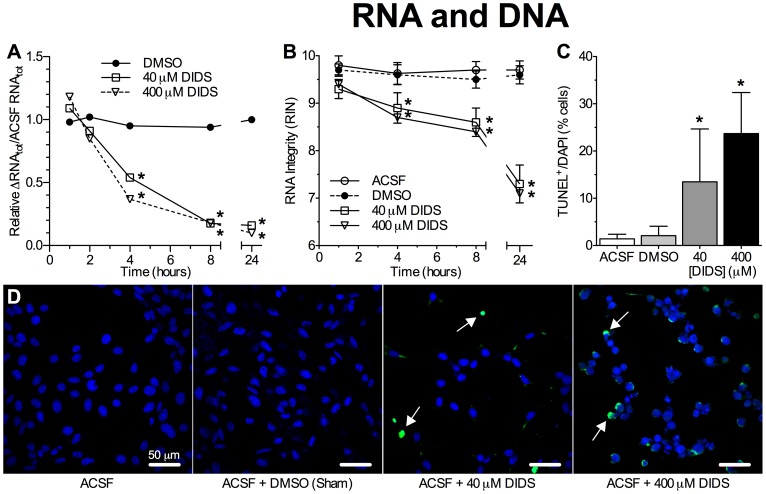
DIDS causes RNA and DNA degradation in a dose-dependant manner.(A&B) Summaries of the effect of ACSF±DMSO±DIDS (40 or 400 µm) on total RNA content (RNAtot) (A) or RNA integrity (RIN) (B) from neurons treated for 1, 2, 4, 8 or 24 hrs as indicated. RNAtot was normalized to untreated samples. RNA experiments were repeated 4 times at each time point. (C) Summary of the ratio of terminal transferase dUTP nick end-labeling (TUNEL)-positive neurons relative to DAPI-stained nuclei from Fig. 6D. (D) Sample confocal microscopy images of TUNEL (green, arrows) and DAPI (blue) fluorescence from neurons treated as indicated for 24 hrs. TUNEL experiments were repeated 4 times. Data are mean ± SEM. Asterisks (*) indicate significant difference from normoxic controls; bars indicate significance between treatments (p<0.05).